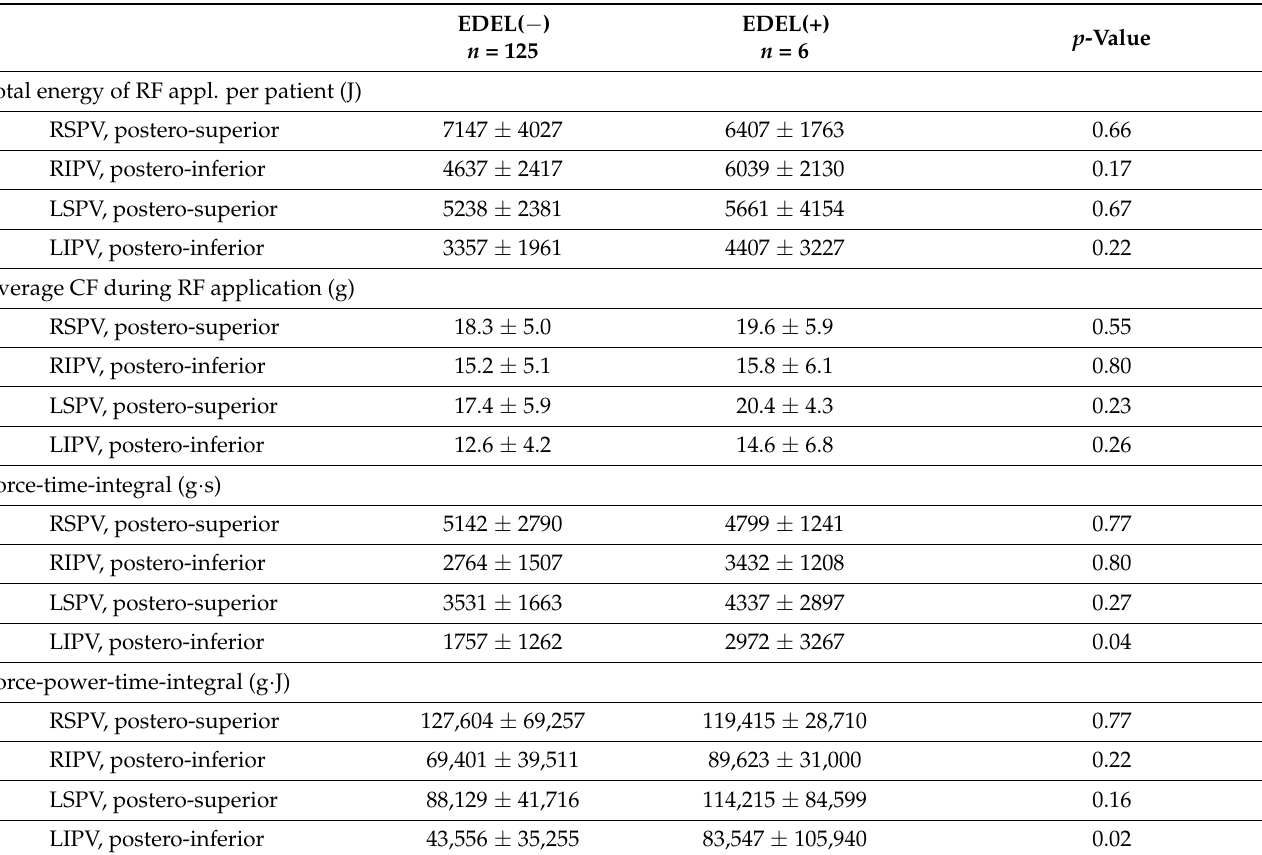
Table 3. Procedural data related to the posterior segments of the wide antral circumferential ablation line around the pulmonary veins.